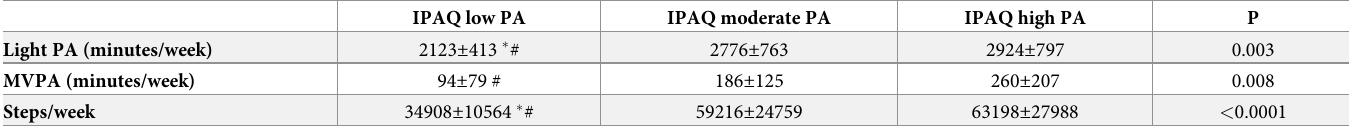
Table 2. Comparisons of objectively measured physical activity variables (assessed by the Actigraph) among the three categories of the International Physical Activ- ity Questionnaire (IPAQ)-short form. IPAQ low PA IPAQ moderate PA IPAQ high PA P Light PA (minutes/week)